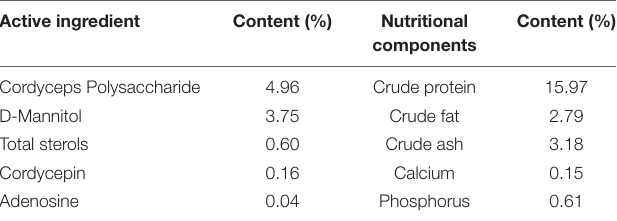
TABLE 2 | Composition of